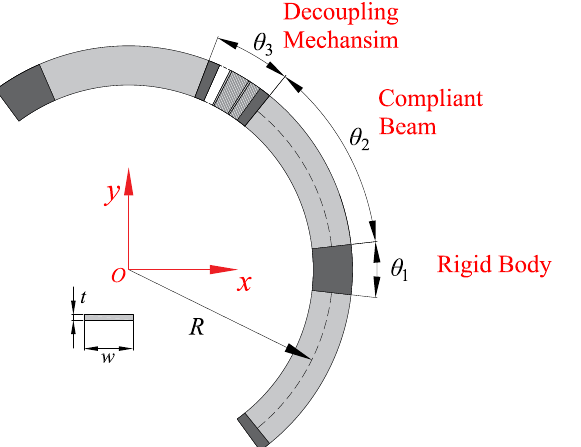
Figure 7. The definition of parameters from the section view of the decoupled linear guide.